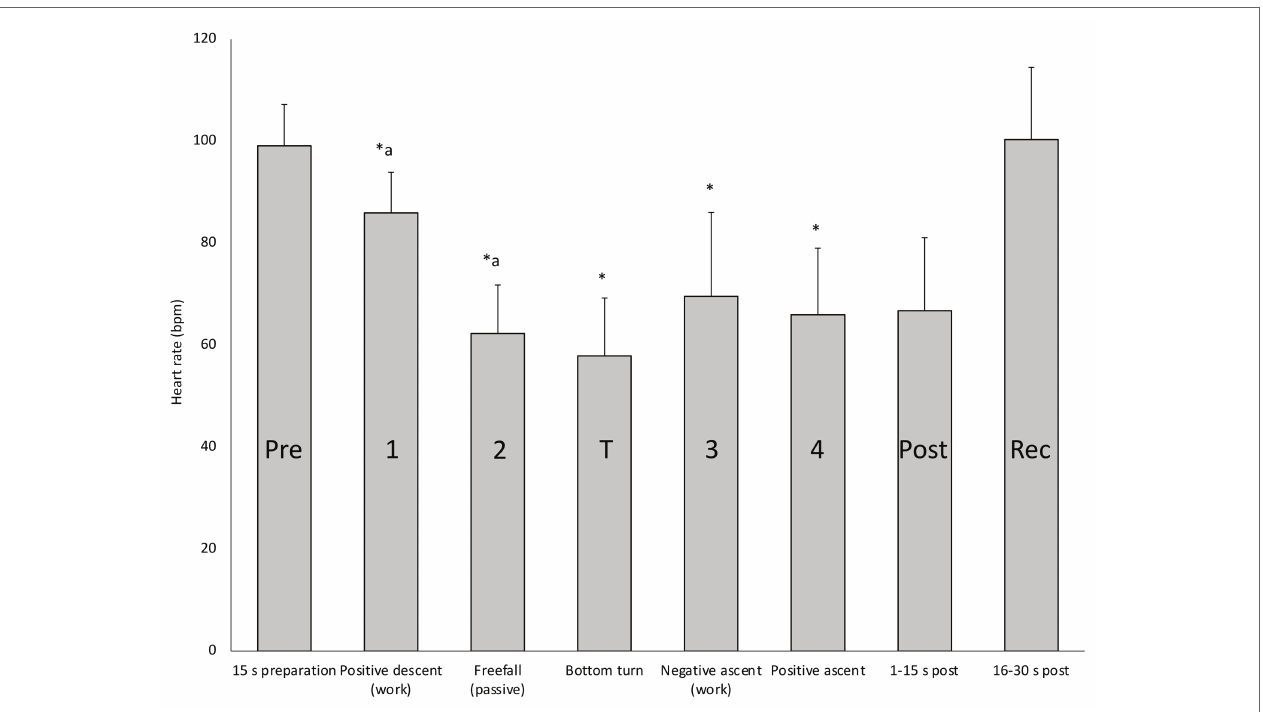
FIGURE 4 | Mean (SD) HR in each of the four deep diving phases, before (Pre) and at the turn of the dives, as well as immediately after surfacing (Post) and during recovery (Rec). ∗ indicates significant difference ( p < 0.05) from the pre-dive value; “a” indicates difference from the previous